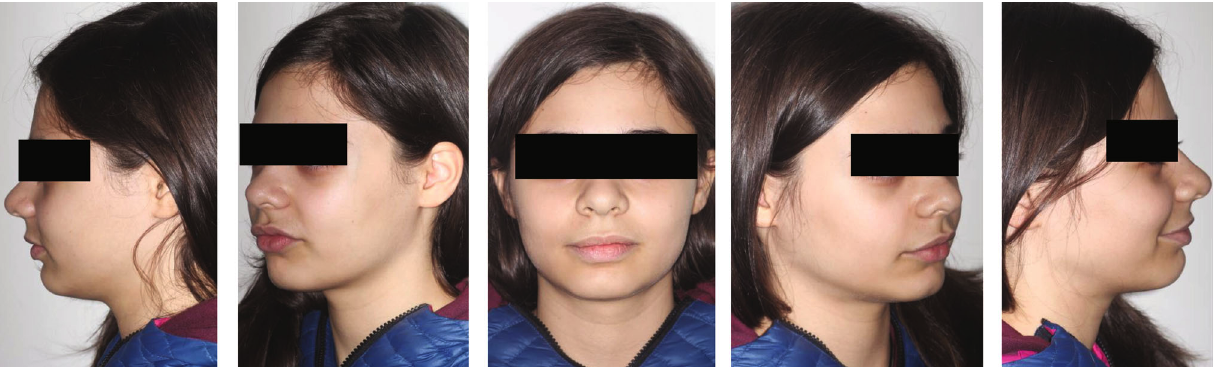
Figure 1: Pre-treatment extraoral photographs.